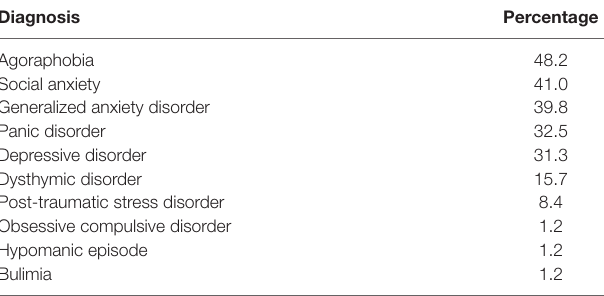
TABLE 1 | Patients’ baseline characteristics: clinical